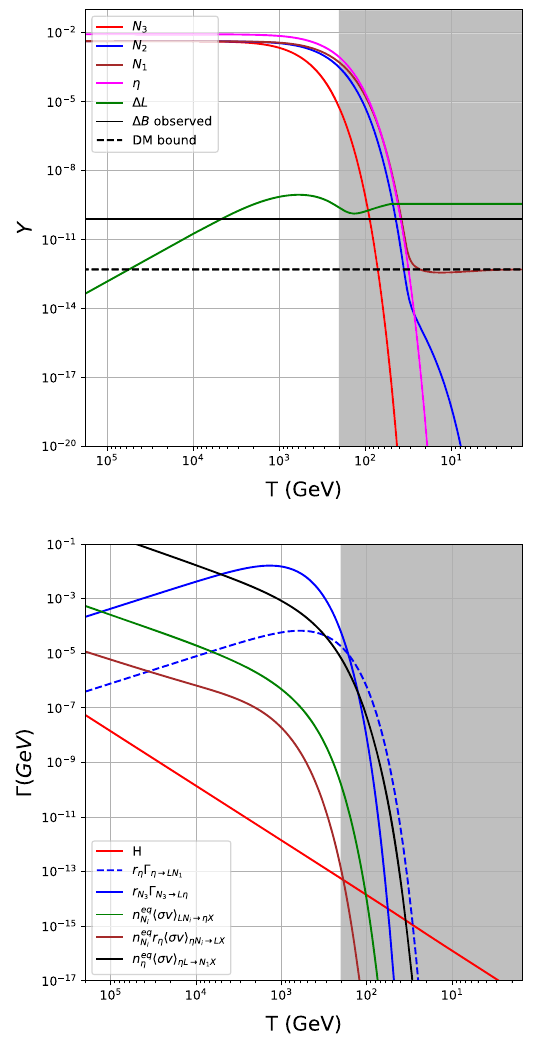
Fig. 6 Top panel: comoving number densities of Z 2 odd particles and lepton asymmetry as a function of temperature for fermion DM scenario. The left (right) panel corresponds to the normal (inverted) hierarchy of neutrino mass spectrum.Bottom panel: rates of individual wash-out processes along with the Hubble rate (left panel); individual